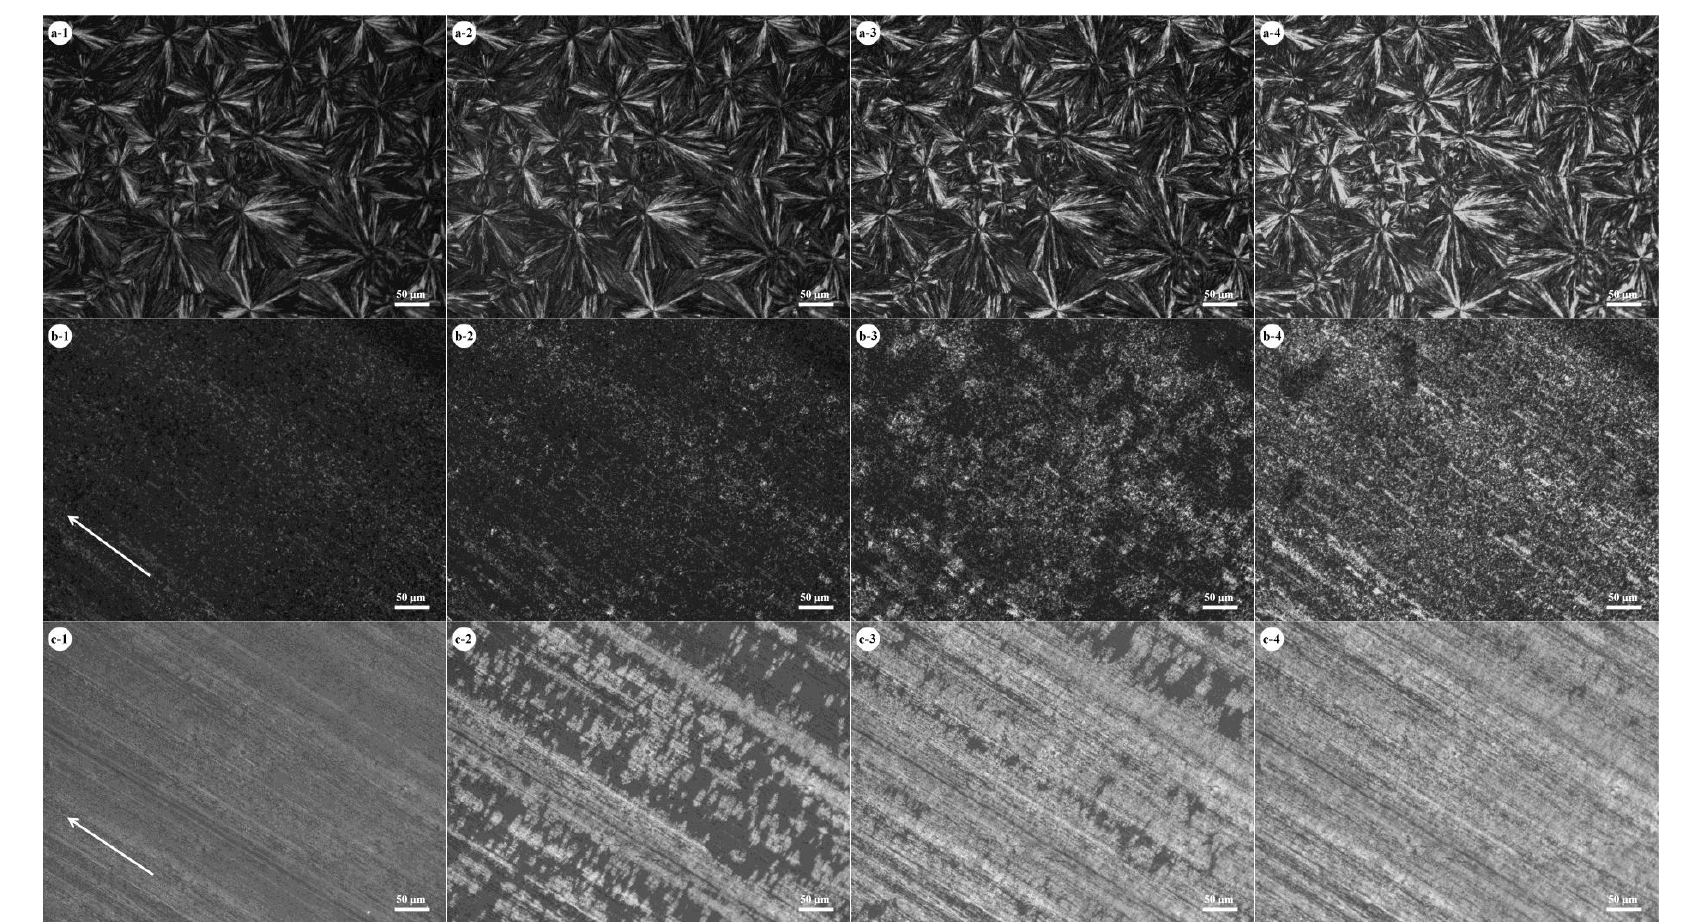
Figure 3. Crystallization of PBA in the 50/50 PBS/PBA blends at 40 °C. ( a-1 – a-4 ) unsheared PBS spherulites, ( b-1 – b-4 ) sheared PBS at 0.004 m/s, and ( c-1 – c-4 ) sheared PBS at 0.008 m/s. The sheared and crystallization temperature of PBS in all samples is 80 °C. The crystallization time of PBA: (−1) 0 min, (−2) 10 min, (−3) 20 min, and (−4) 40 min. The arrow in ( b-1 , c-1 ) indicates the shear orientation.